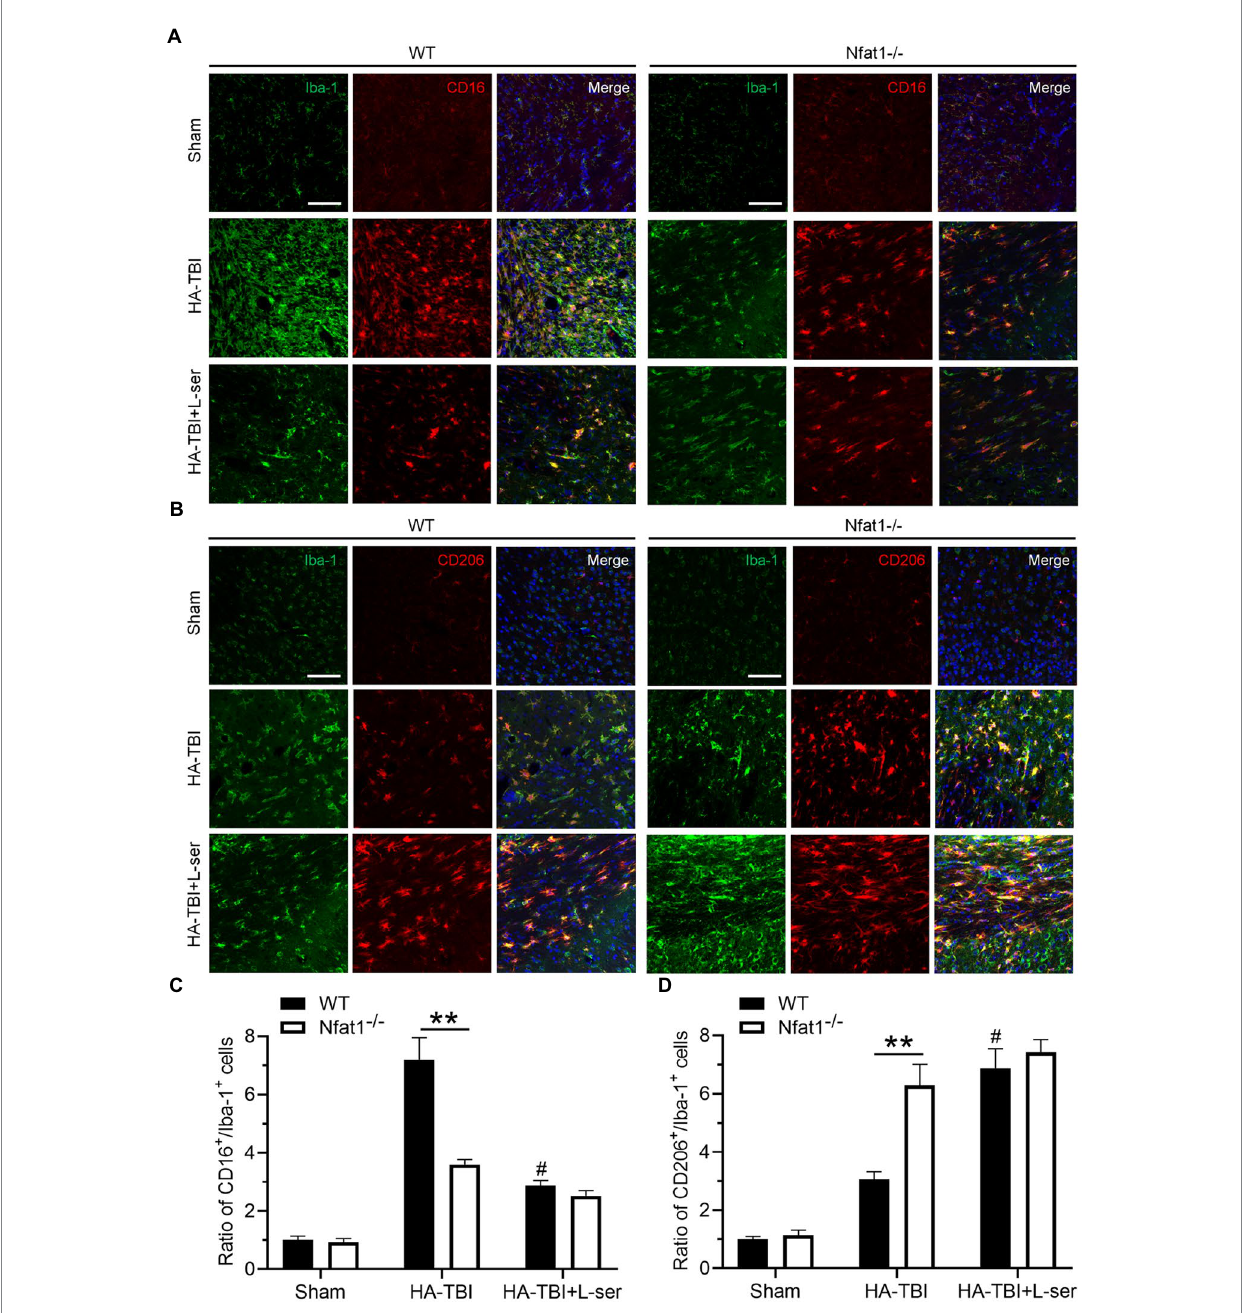
FIGURE 7 Effects of L-serine on the polarization of microglia in WT mice and Nfat1 knockout mice after HA-TBI. (A) Representative images of double immunofluorescence staining of Iba-1 and CD16 in sections 0.5 mm anterior to the bregma in different groups 7 days post HA-TBI. (B) Representative images of double immunofluorescence staining of Iba-1 with CD206 at the section 0.5 mm anterior to the bregma in different groups 7 days post HA- TBI. (C) Relative cell counts of colabelled CD16 + /Iba-1 + cells in the lesion sites shown in A. (D) Relative cell counts colabelled for CD206 + /Iba-1 + in the lesion sites as shown in B. n = 6; Scale = 50 μ m. ** p < 0.01 versus the indicated group; # p < 0.01 versus the HA-TBI group of